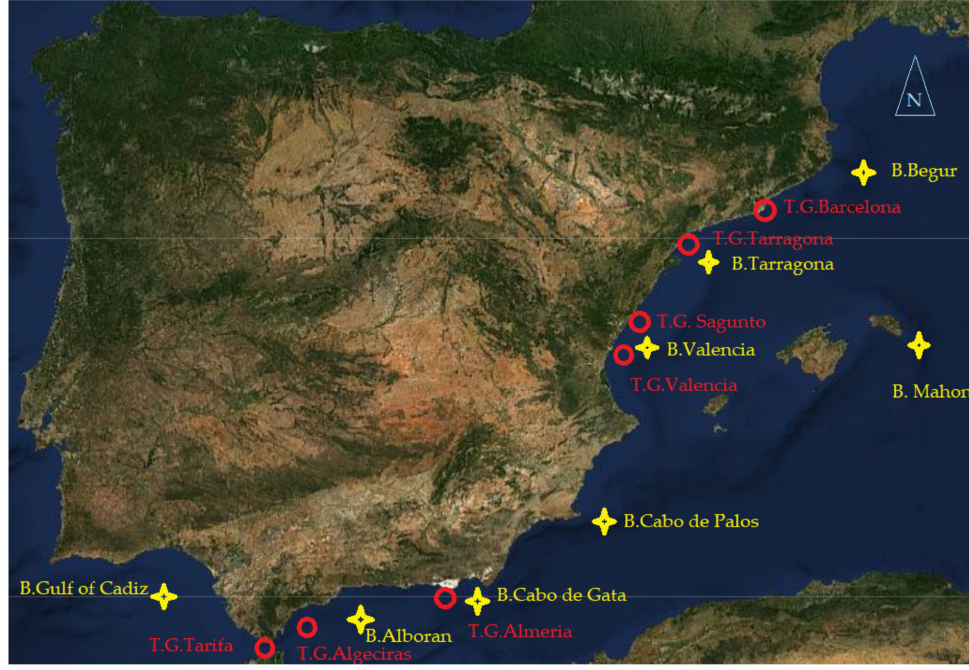
Figure 2. Buoys and tide gauges used in the